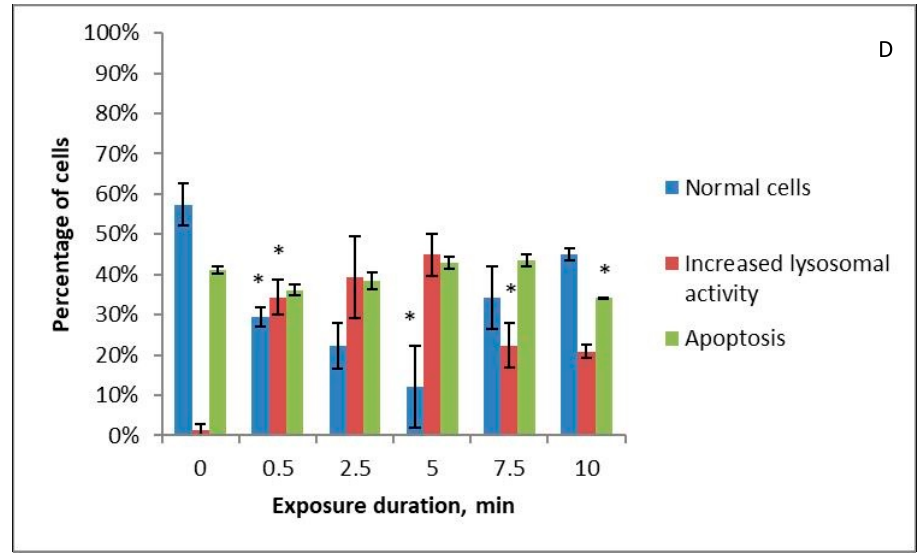
Figure 6. Changes in the apoptotic and increased lysosomal activity of K562 myeloid leukaemia cells under the influence of 0.9% NaCl solution ( A ), Ringer’s solution ( B ), and Hank’s Balanced Salt Solution ( C ) or Hank’s Balanced Salt Solution with the addition of amino acids in physiological concentrations ( D ) treated with piezoelectric direct discharge for a specific period of time with simultaneous addition of medroxyprogesterone acetate to the nutrient medium. The * sign indicates a statistically significant difference from a shorter treatment time ( p < 0.05).